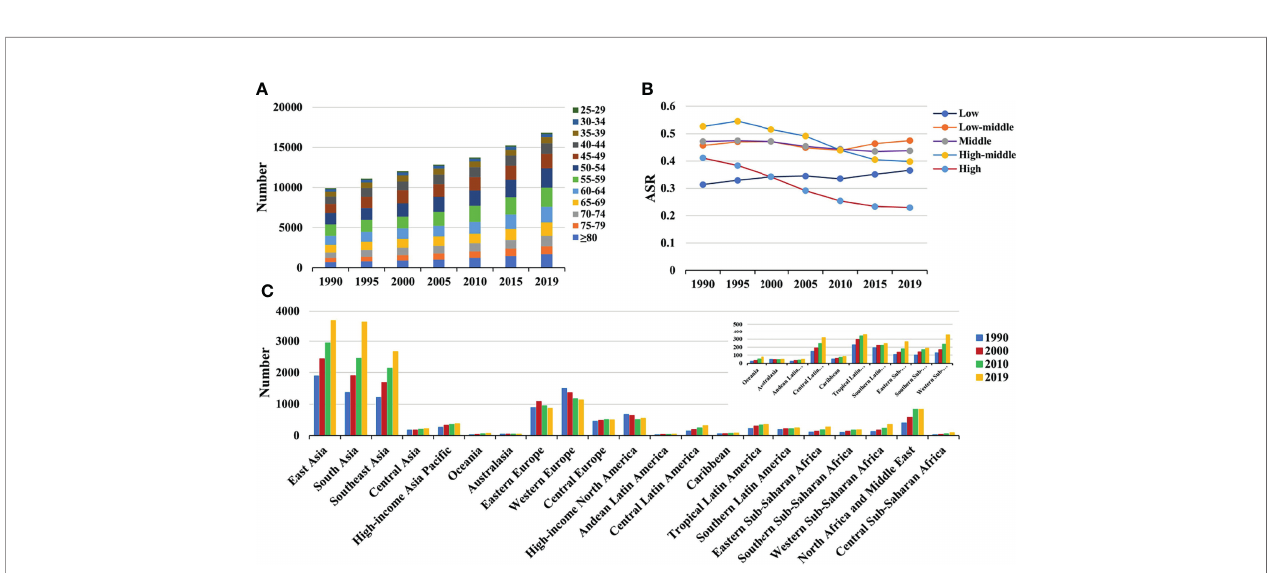
FIGURE 2 | The distribution of death caused by breast cancer attributable to secondhand smoke from 1990 to 2019. (A) was the death number in age groups; (B) was the ASDR in SDI areas; (C) was the death number in geographical regions. ASDR, age-standardized death rate; SDI, sociodemographic